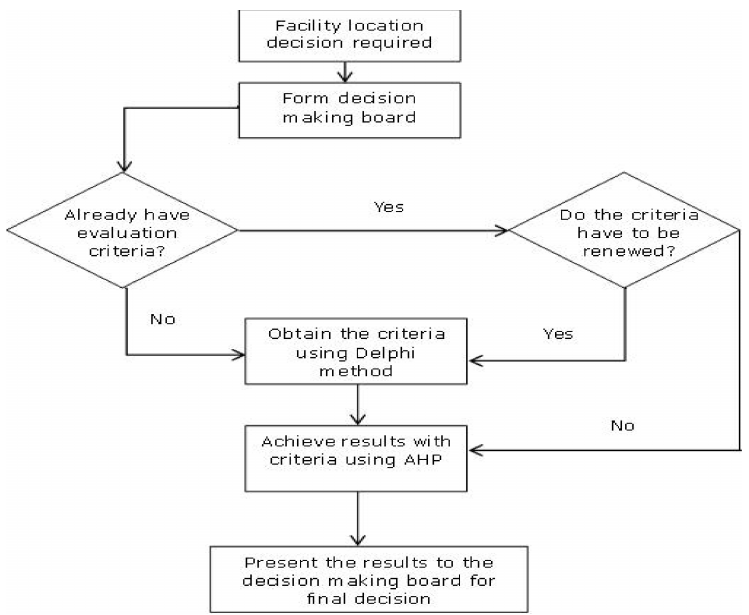
Figure 2. Process flow in location